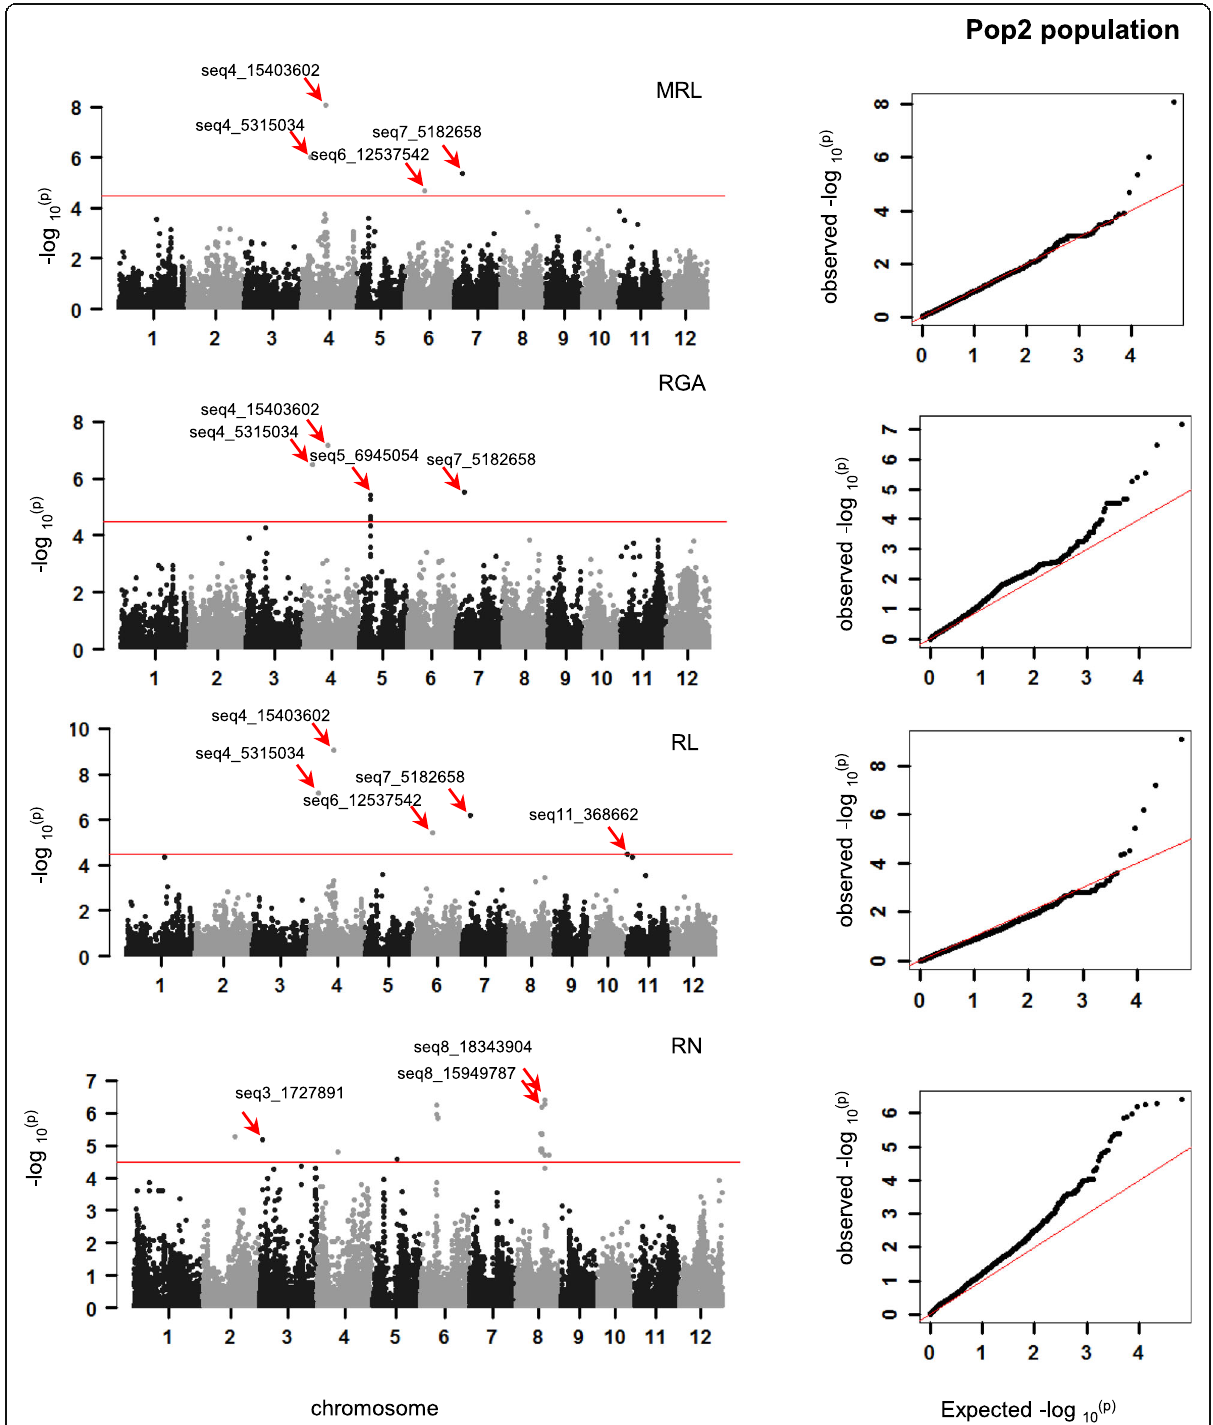
Fig. 4 GWAS for rooting ability – related traits in the Pop2 association panel. Manhattan plots and quantile-quantile plots for MRL ( a ), RGA ( b ), RL ( c ), and RN ( d